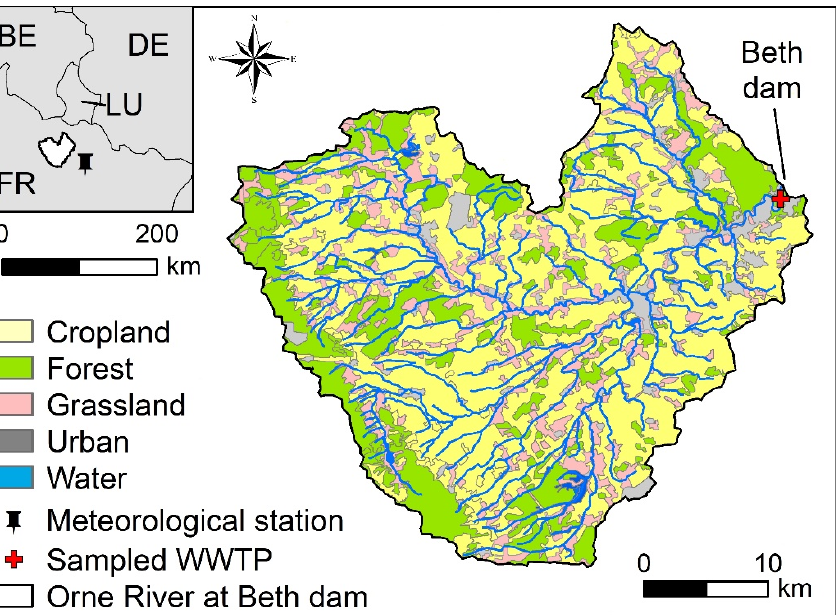
Figure 1. Land use map of the Orne River basin at the Beth sampling site. Location of the meteoro- logical station (Météo France, Aéroport M.N.L.) and sampled wastewater treatment plant (WWTP). Source land use map: European Environment Agency-Corine Land Cover 2018. Catchment and river network delineated using the digital elevation model MNT BD ALTI ® (Source: National Institute of Geographic and Forest Information (IGN-F), France) and the program ArcGIS 10.5.